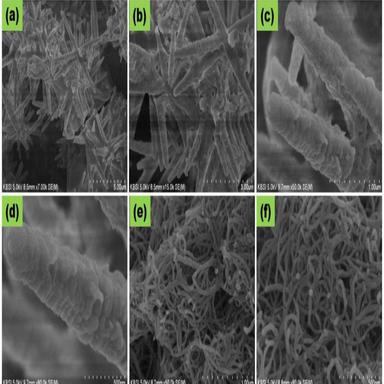
High-resolution HR-SEM images of (a), (b), (c), (d) ZnO/NiS and (e), (f) of ZnO/NiS/CNT and their corresponding high magnification images.